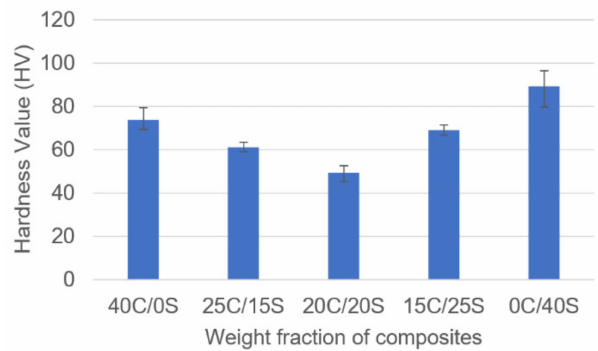
Figure 10. Hardness vs. weight fraction of C/S